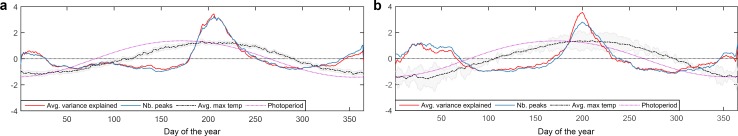
Variance explained averaged over all seasonally periodic words and total number of seasonally periodic words peaking per day in (a) the UK corpus and (b) the US corpus, compared with the maximum daily temperature and photoperiod in each geographical region respectively. Each series is standardized while the two former series were first smoothed using a 15-day centred moving average. The grey area represents the 99% confidence interval for the Temperature series. We can see that the average variance explained per day and the number of seasonal words peaking per day correlates more closely with the temperature, rather than the photoperiod, with most words peaking at the warmest and coldest time of the year. This suggests that activities are driven by temperature, rather than by day-length.